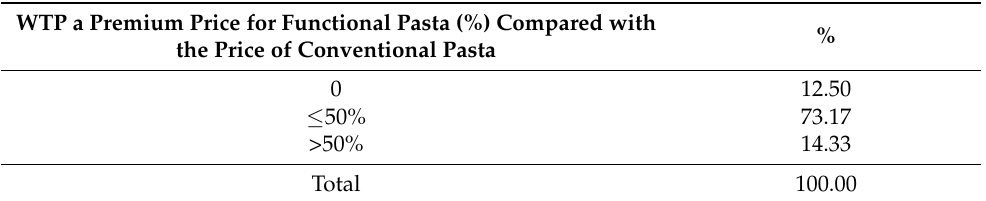
Table 1. Distribution of the three levels of the dependent variable (N = 342). WTP a Premium Price for Functional Pasta (%) Compared